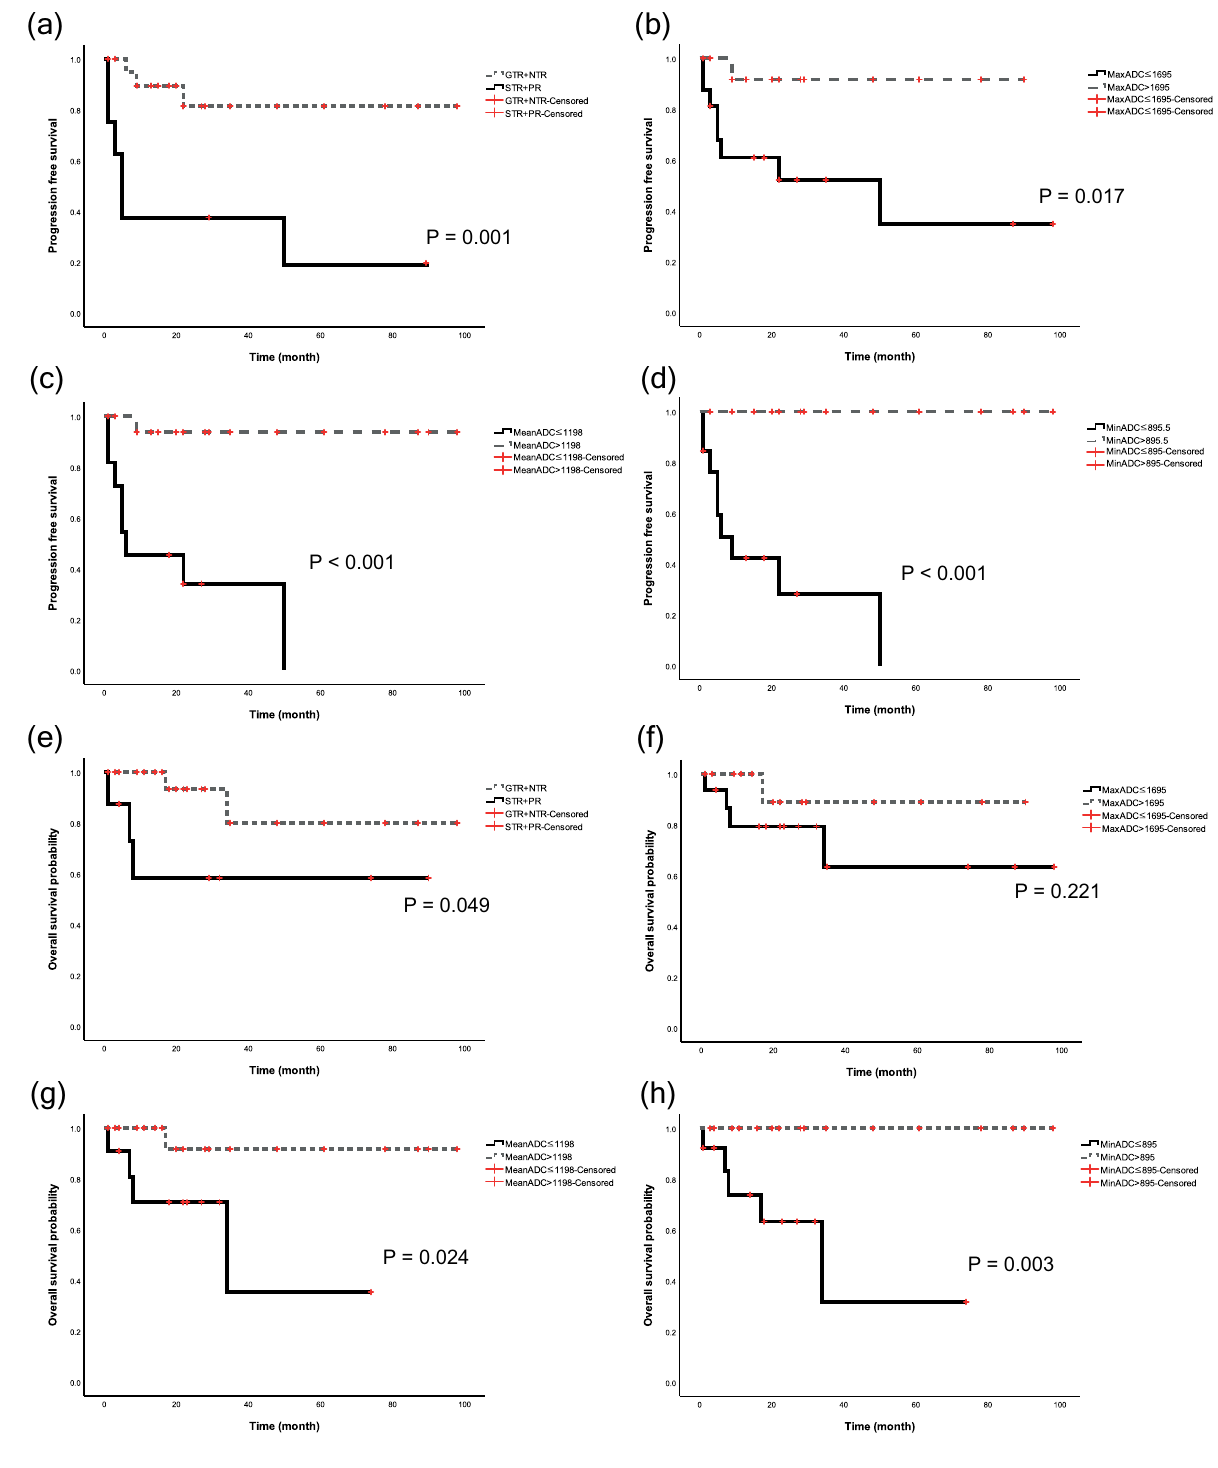
Figure 3. Kaplan–Meier curves using log-rank tests for overall survival and progression-free survival: ( a ) PFS according to extent of tumor resection; ( b ) PFS according to maximum ADC values; ( c ) PFS according to mean ADC values; ( d ) PFS according to minimum ADC values; ( e ) OS according to extent of tumor resection; ( f ) OS according to maximum ADC values; ( g ) OS according to mean ADC values; and ( h ) OS according to minimum ADC